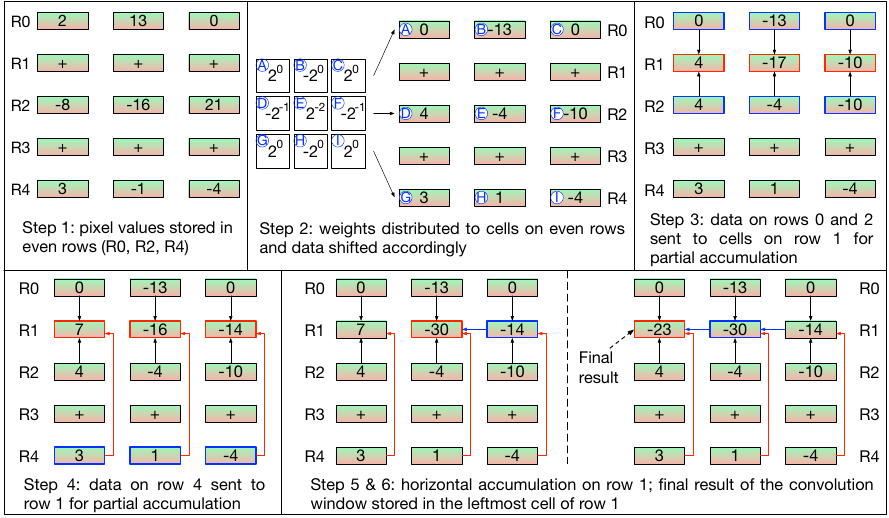
Figure 13. Management of convolution computation inside the CLiM